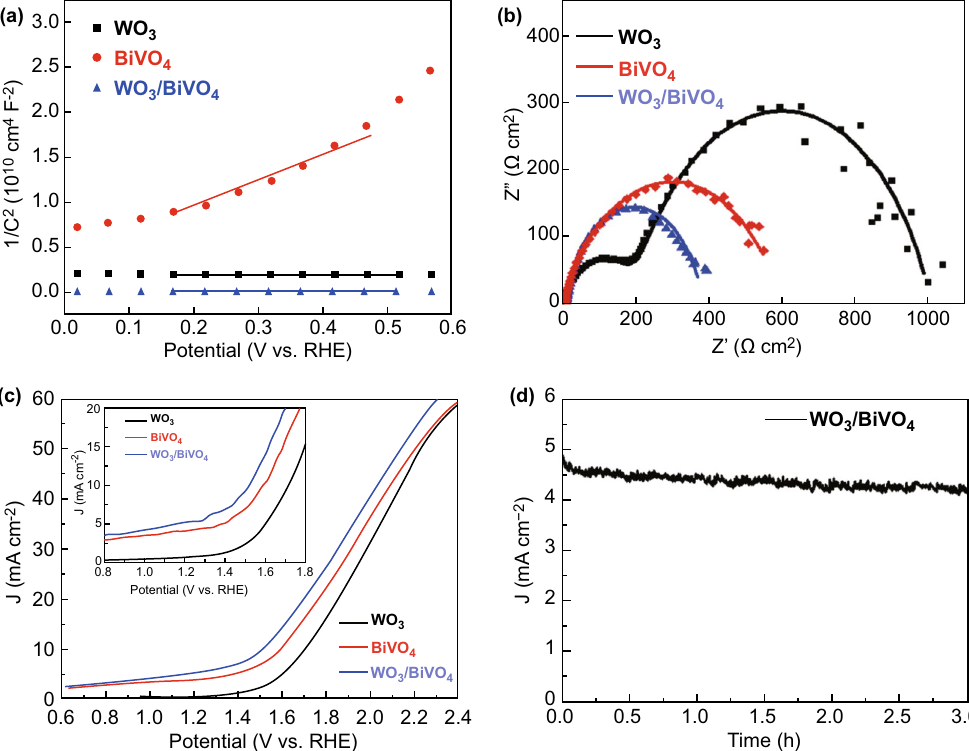
Fig. 2 Photoelectrochemical performances of WO 3 /BiVO 4 photoanodes. a Mott–Schottky plots and b EIS spectra of the photoanodes at 1.23 V versus RHE. c J – V curves of the photoelectrodes measured in phosphate buffer (0.5 M, pH = 7) including Na 2 SO 3 (1 M) as hole scavenger. The inset exhibits the enlarged image of the potential (0.8–1.8 V vs. RHE). d Photochemical stability of the WO 3 /BiVO 4 (1.23 V vs.